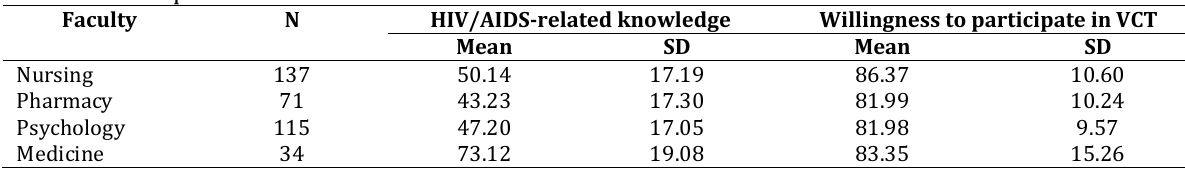
Table 4. Least Significant Difference (LSD) Test Results: multiple